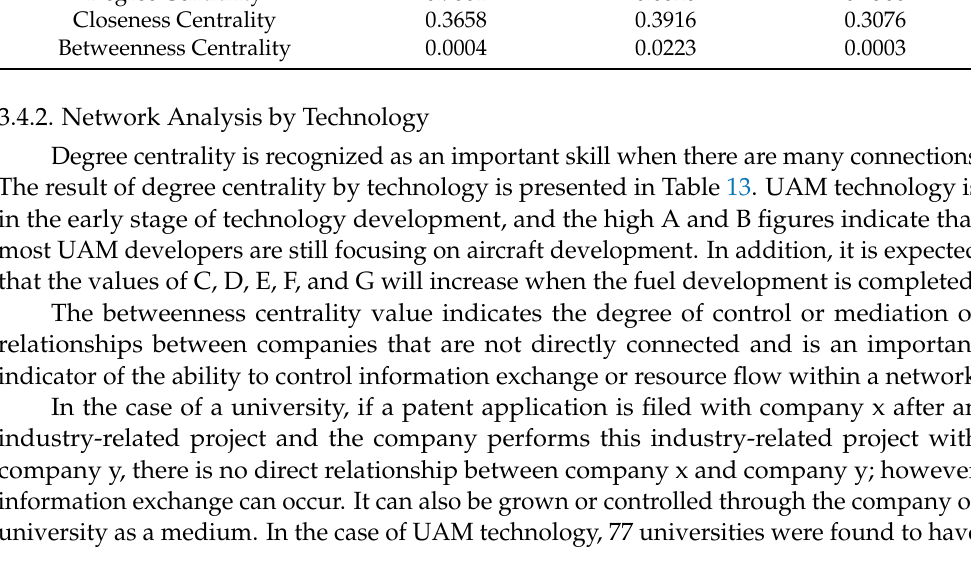
Table 12. Centrality index comparison by company.